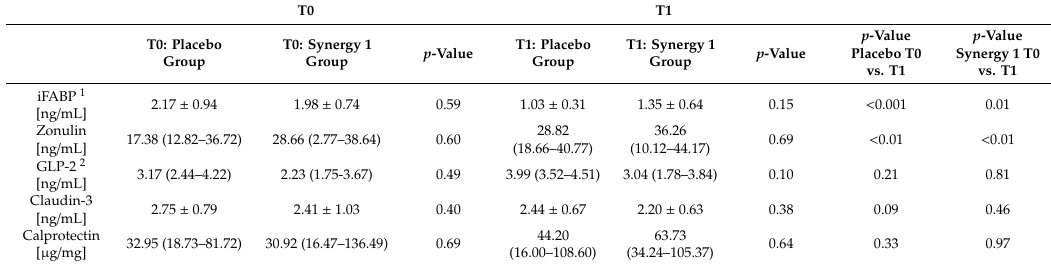
Table 1. The results of the intestinal permeability markers at baseline (T0) and after the intervention (T1). Quantitative variables with a normal distribution were expressed as mean ± SD, quantitative variables which showed a non-normal distribution were expressed as median